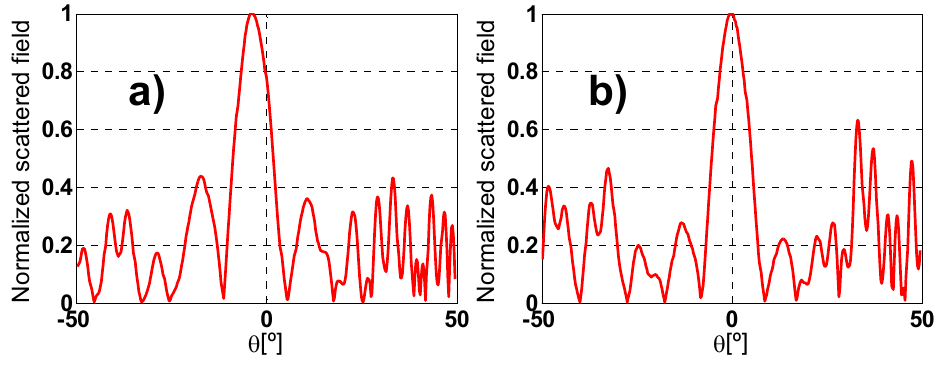
Figure 14. Scattered field pattern in anechoic chamber at 6.3 GHz: ( a ) TE MMA and ( b ) TM metallic